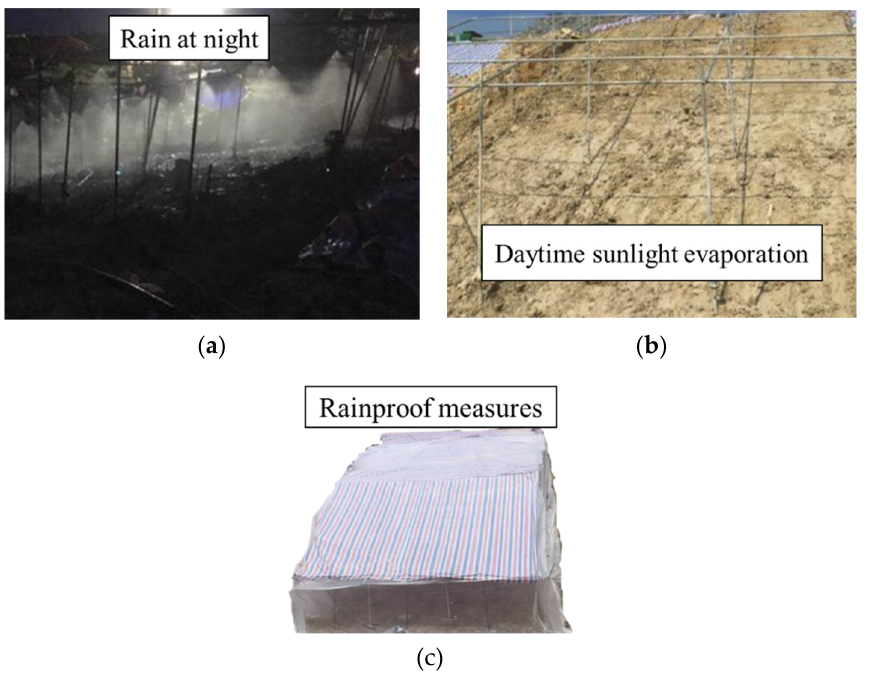
Figure 7. Dry and wet cycle simulation test: ( a ) rain at night; ( b ) dry during the day; ( c ) rainproof measures. Table 3. Experimental history.